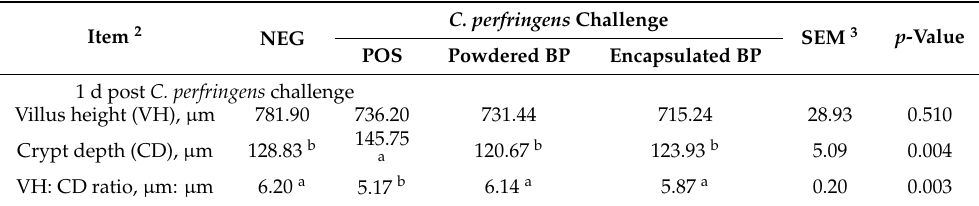
Table 4. Effects of dietary encapsulated and powder BPs on the ileal morphology of broiler chicken challenged with C. perfringens 1 .